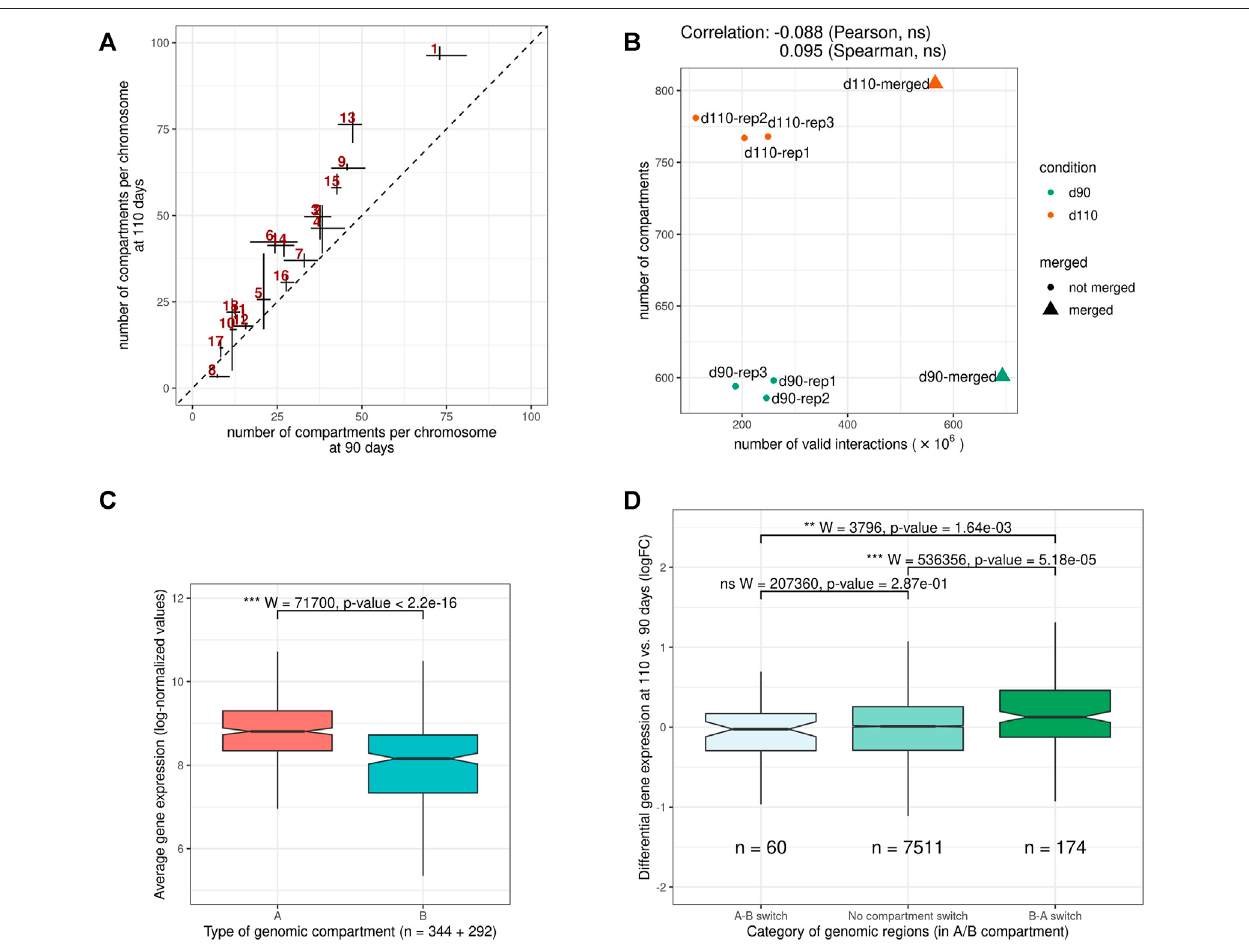
FIGURE 4 | Features of A/B genomic compartments (A) Average number of compartments per chromosome at 90 and 110 days of gestation. The dotted line indicates y (cid:2) x (B) Relation between the number of valid interactions in each matrix and the number of compartments. Unlike for TADs ( Figure 3B ), no impact was detected (C) Average expression of genes in A vs B compartments. Gene expression data were obtained from a previous study of fetal muscle samples at 90 and 110 days of gestation Voillet et al. (2014) (D) Distribution of differential expression values (logFC) for genes in genomic regions (left) switching from an A compartmentat90 daystoaBcompartmentat110 days(A-Bswitch) (middle) showingnocompartmentswitch (right) switchingfromaBcompartmentat90 daysto an A compartment at 110 days (B-A switch). See also Supplementary Figures S1 and S2